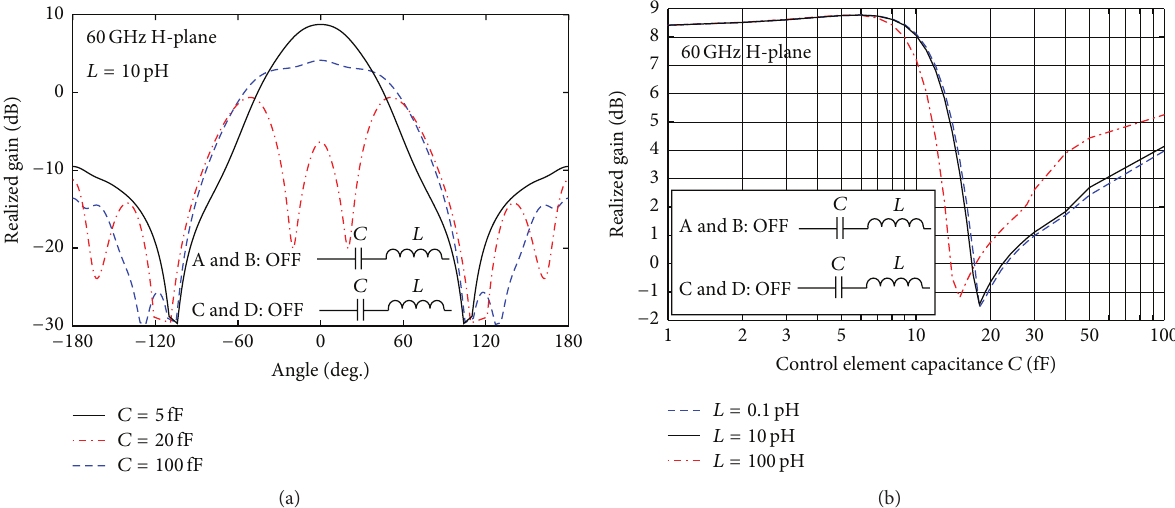
Figure 13: Radiation patterns in the antenna H-plane (a) and realized gain (b) at 60GHz for the reconfigurable antenna with A, B, C, and D control elements in “OFF”